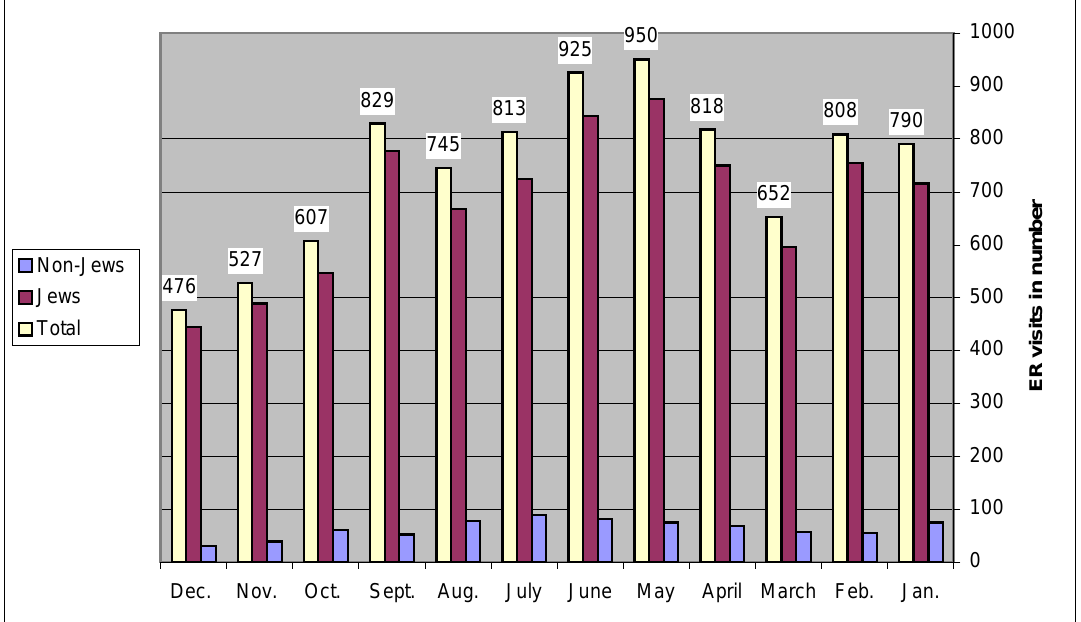
FIGURE 3. Seasonal variations, numbers of emergency room visits by month-end, ethnicity.